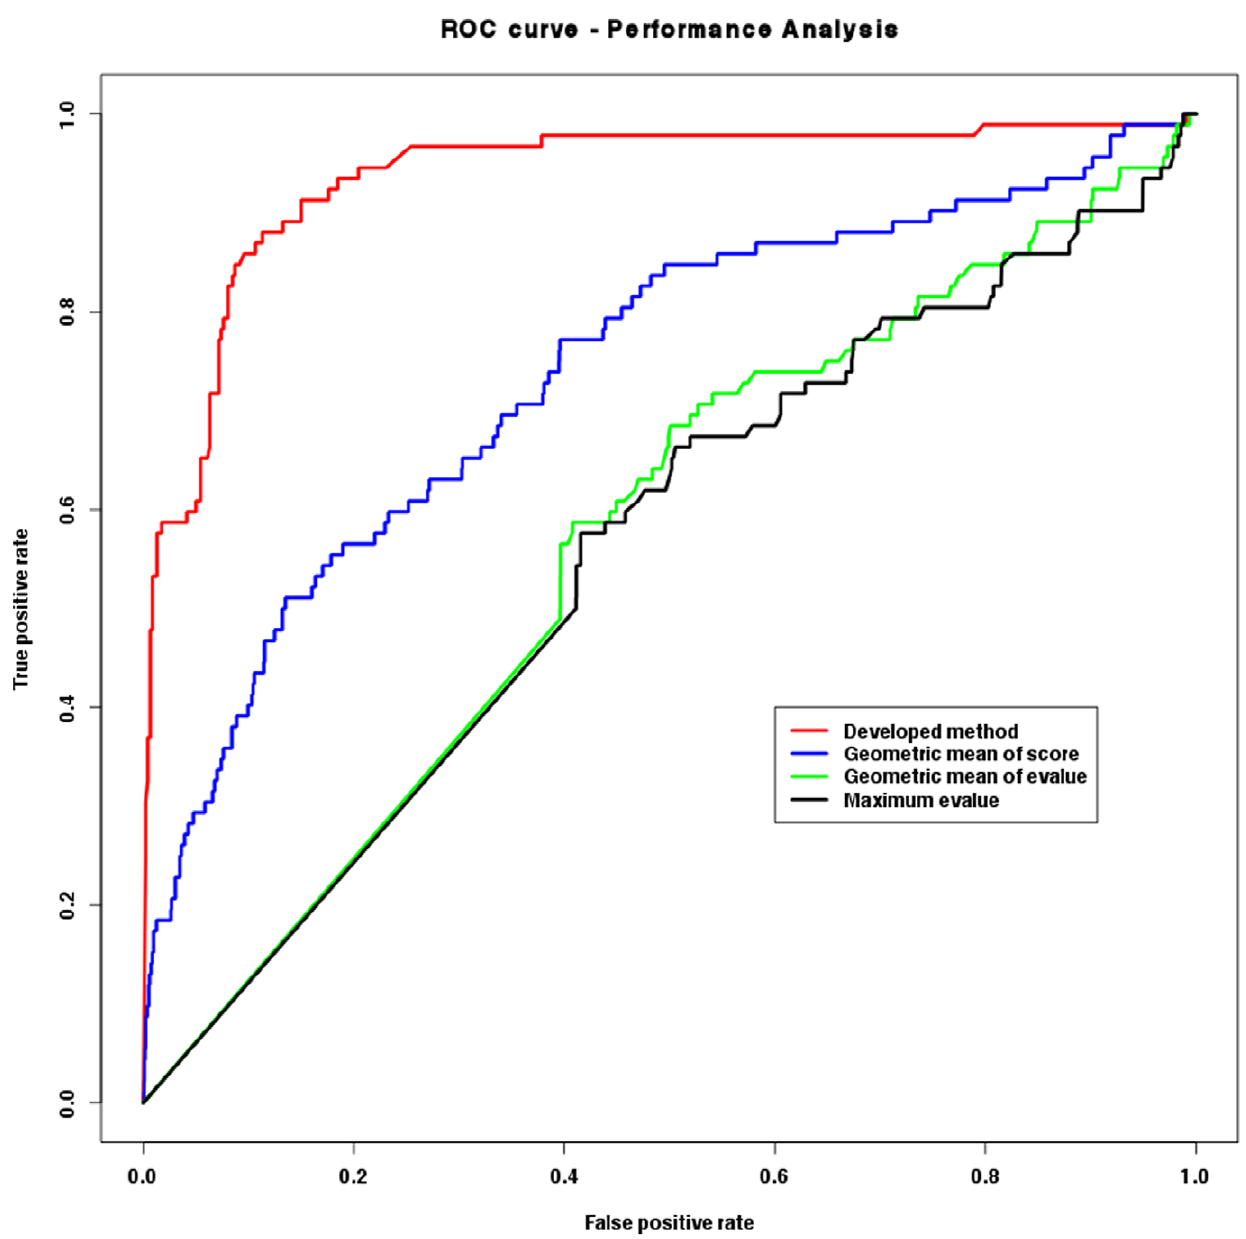
Figure 1. Performance evaluation of approached used to predict PPI networks using the ROC curve. Here the predictions were compared against a gold standard data of interactions extracted from DIP database for E. coli (see text for details).